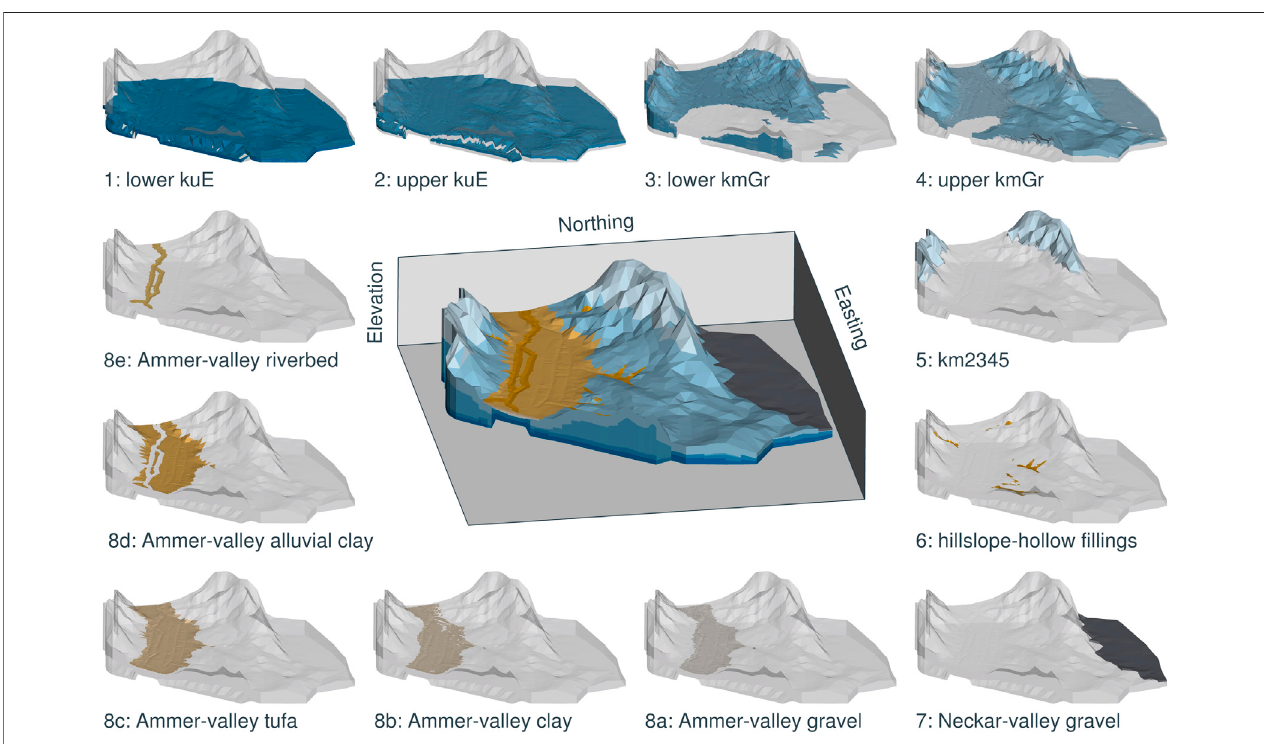
FIGURE 4 | Three-dimensional overview of the subsurface- fl ow model. The vertical dimension is exaggerated by a factor of fi ve to enhance distinctness.